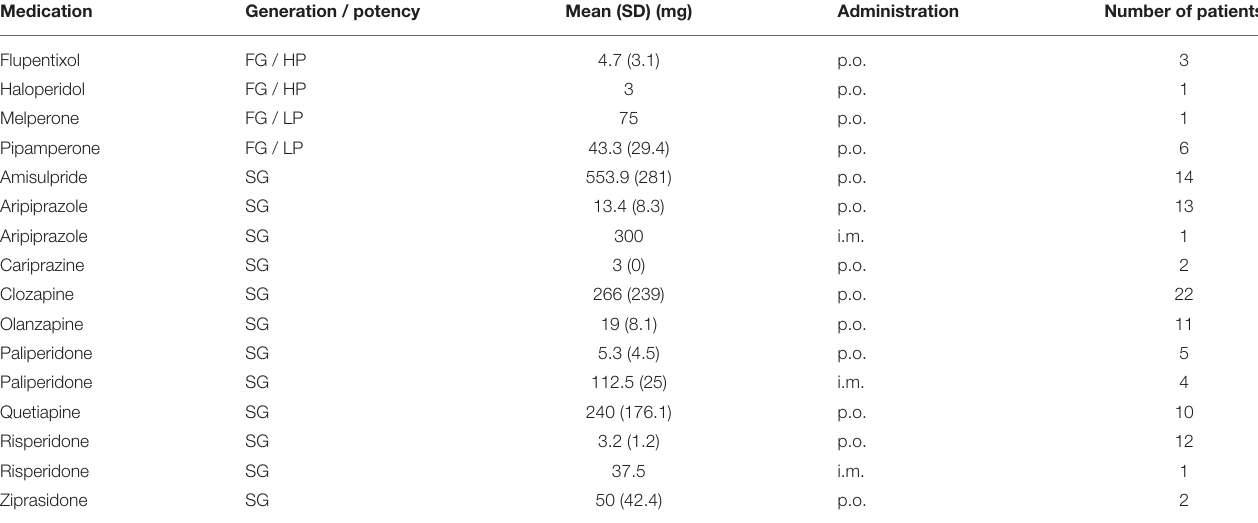
TABLE 2 | Overview of the antipsychotics taken during the